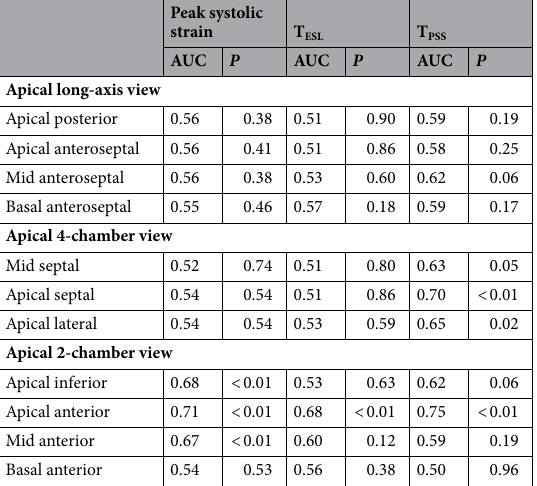
Table 2. Receiver operating characteristic curve analysis for differentiating the single-vessel group from the no stenosis group. P values versus the line of random chance (AUC = 0.5). AUC, area under the curve.